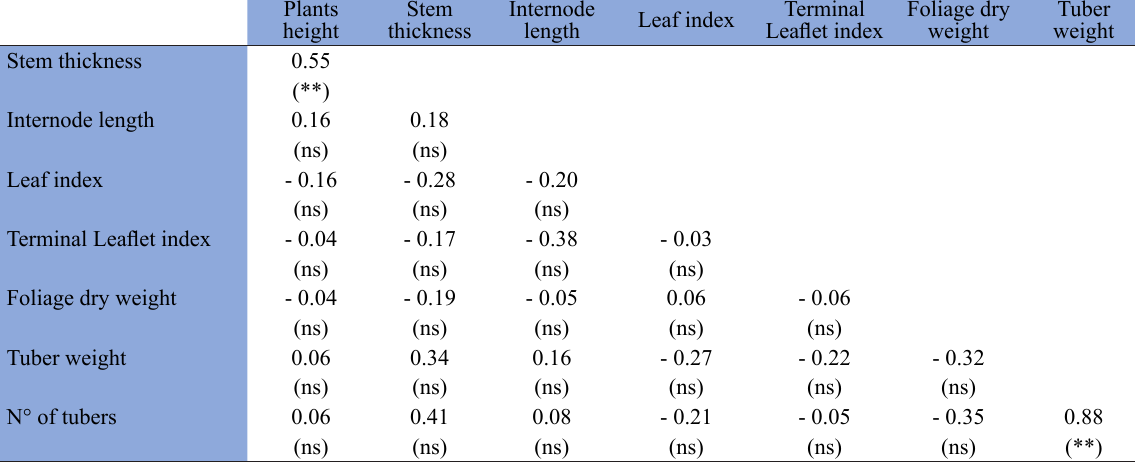
ns = non-significant Table 3: Correlations between characteristics of morphotypes under Restricted Irrigation (RI) Plants height